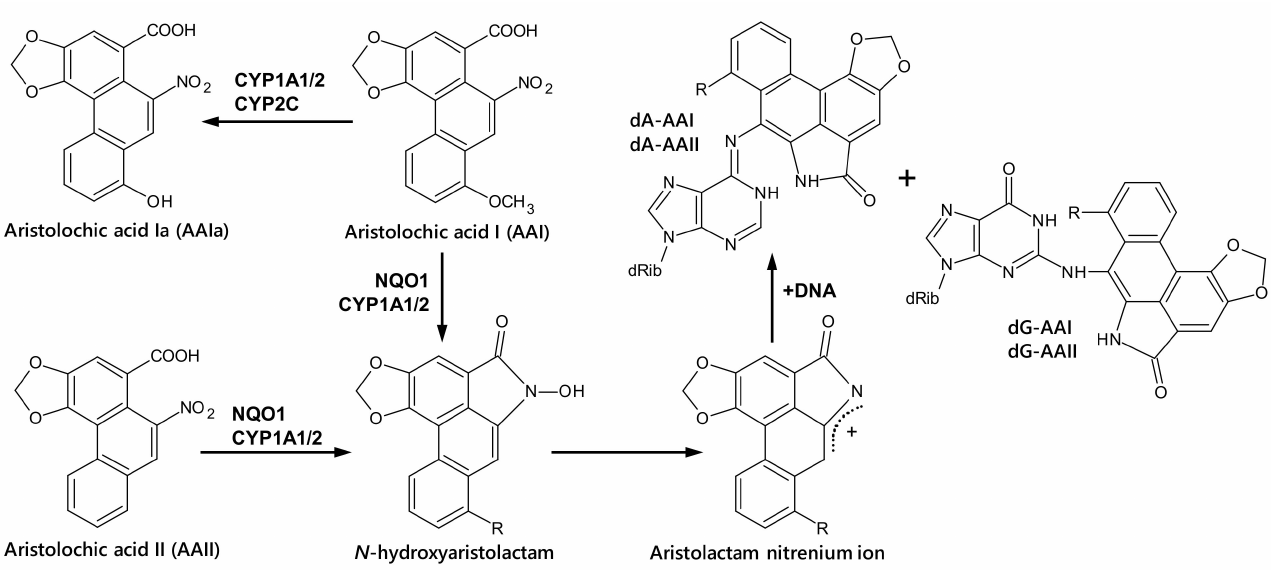
Figure 1. Pathways of bioactivation and DNA adduct formation by AAI and AAII: 7-(deoxyadenosin- N 6 -yl)-aristolactam I (dA-AAI); 7-(deoxyguanosin- N 2 -yl)-aristolactam I (dG-AAI); 7-(deoxyadenosin- N 6 -yl)-aristolactam II (dA-AAII); 7- (deoxyguanosin- N 2 -yl)-aristolactam II (dG-AAII). See text for